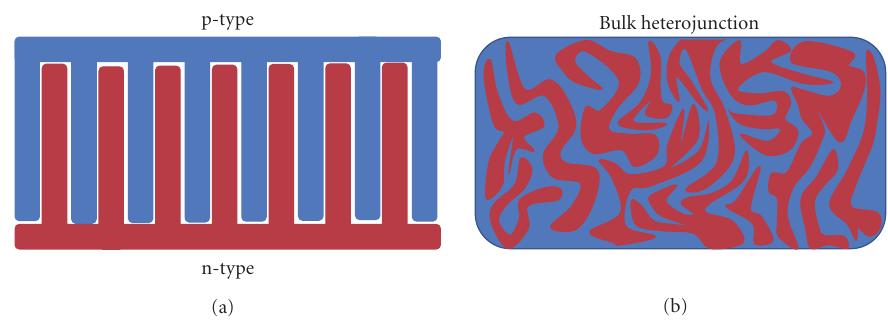
Figure 7: (a) The ideal device architecture. (b) BHJ